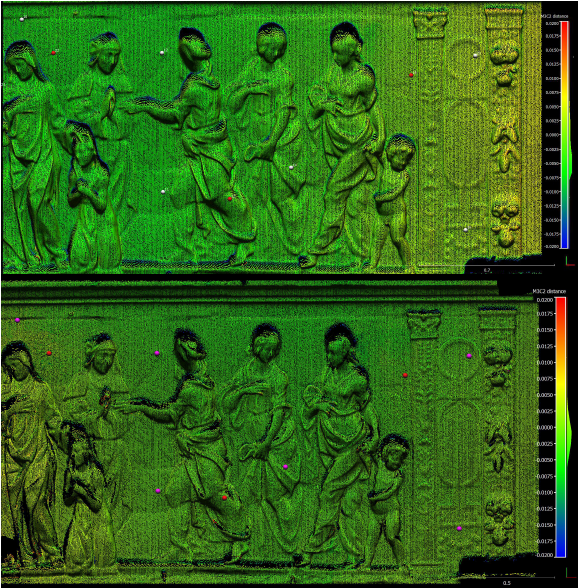
Figure 10. The same part of the frieze as resulting from the alignment process of a complete dataset (object size approx.